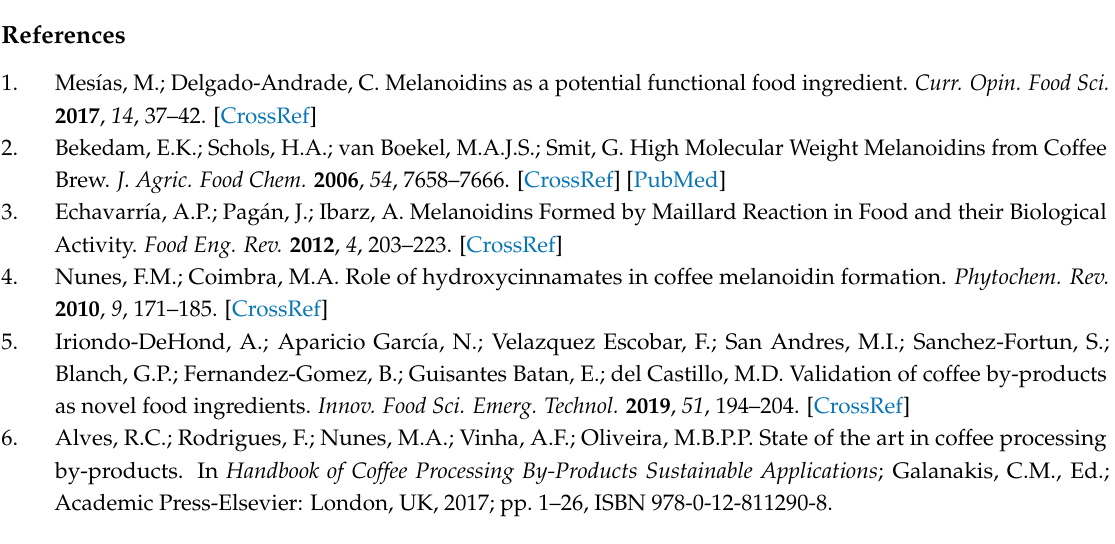
Table S1: Effect of melanoidin consumption on body weight, normalized rat organs weight (g/kg rat), and length of the small intestine and colorectum (cm) of the control ( n = 8) and the treated rats ( n = 6). Values represent the mean ± SEM. Asterisk denotes significant difference compared to the control (Student’s t -test, * p <